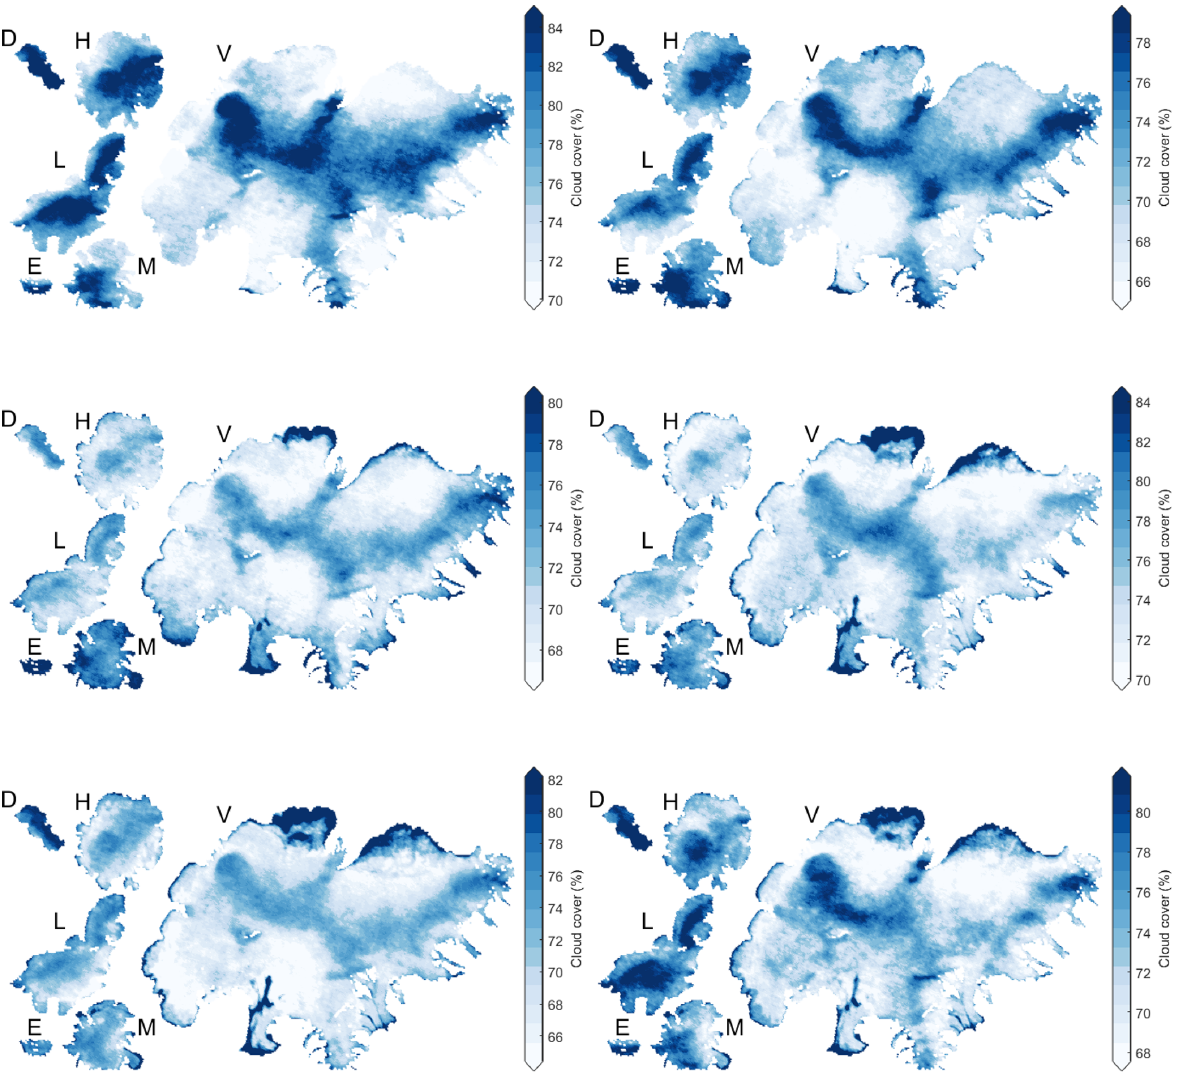
Figure A1. Monthly average cloud cover for selected glaciers in Iceland in April (top left), May (top right), June (middle left), July (middle right), August (bottom left), and September (bottom